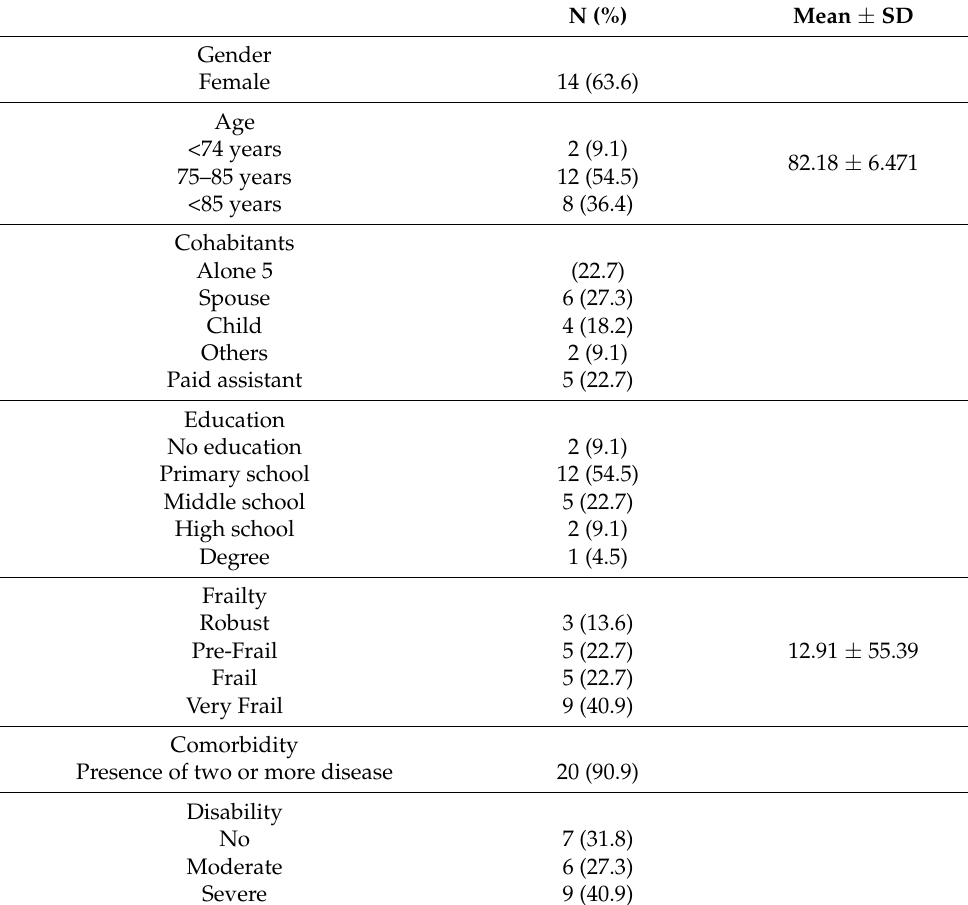
Table A1. Sociodemographic characteristics of the sample lost at Follow-Up (N =